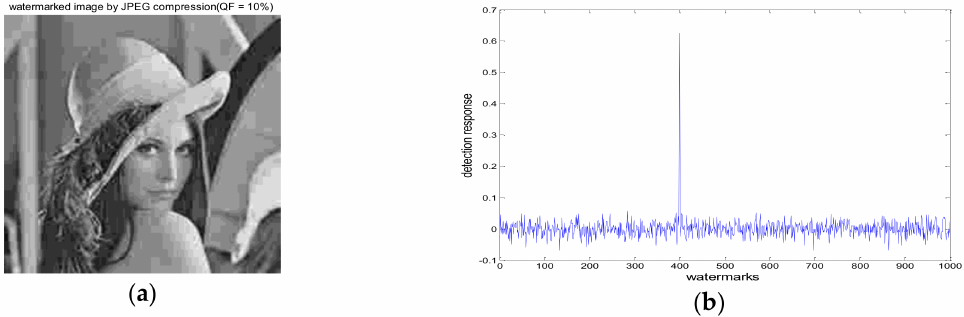
Figure 7. ( a ) JPEG compression; ( b ) detector response.